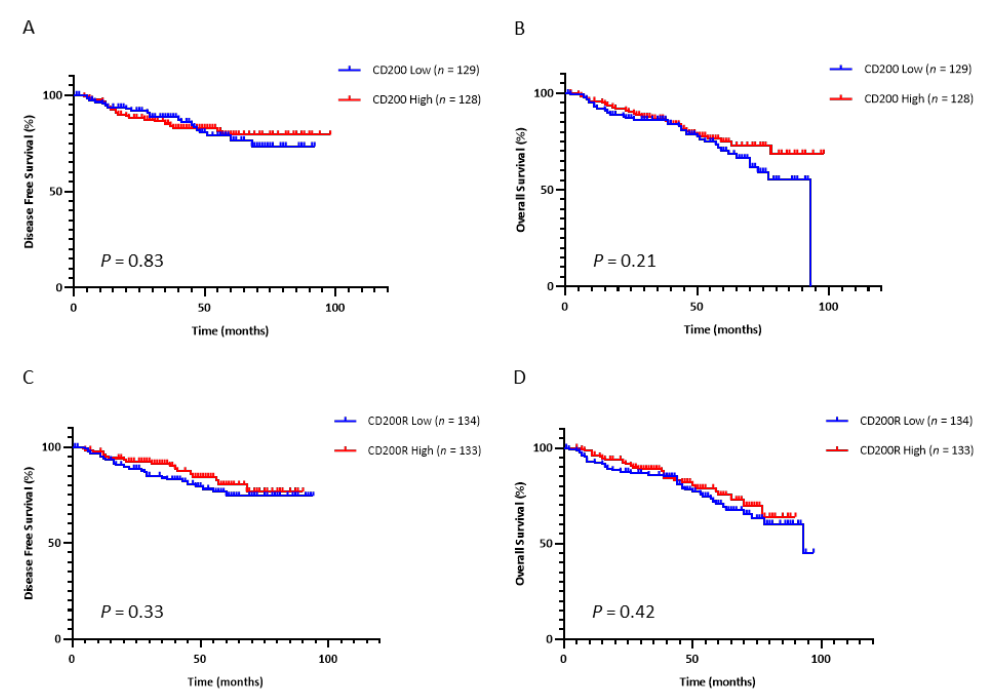
Figure 3. Prognostic performance of CD200 and CD200R. ( A , B ) Kaplan–Meier curves for disease-free ( A ) and overall survival ( B ) with respect to expression of CD200 in the tumor compartment. ( C , D ) Kaplan–Meier curves for disease-free ( C ) and overall survival ( D ) with respect to expression of CD200R in the stromal compartment.